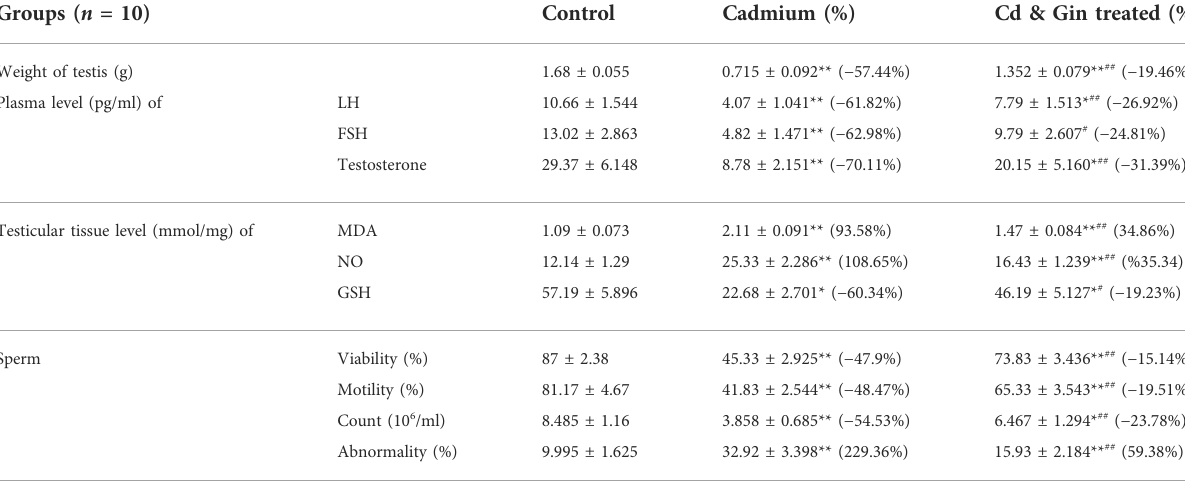
TABLE 1 Comparison of the weight of testis, plasma levels of hormones, testicular tissue levels of cytokines and sperm parameters among the study groups. Groups ( n =